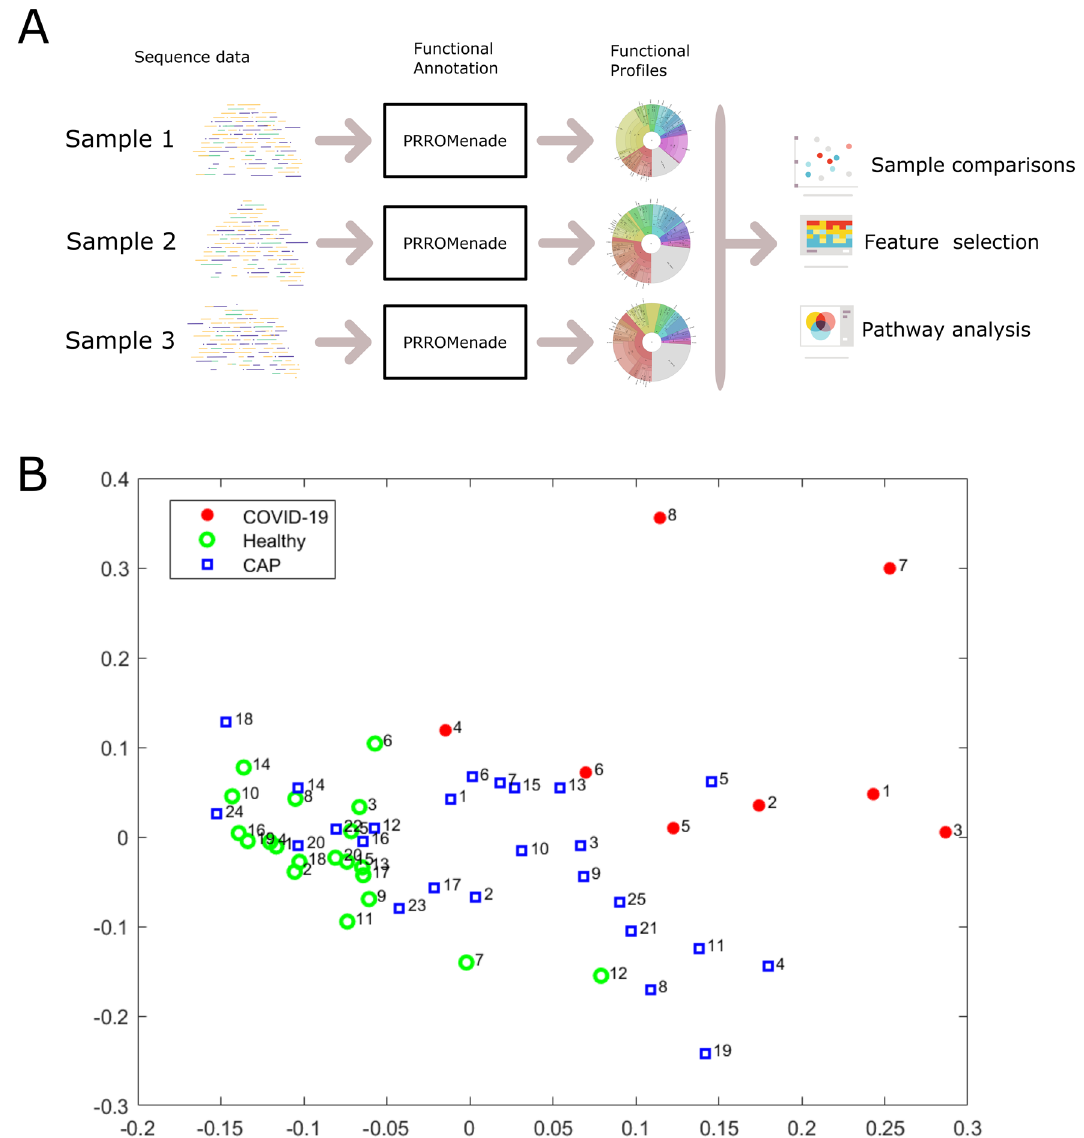
Figure 1. Overall analysis workflow and two-dimensional projection of functional profiles. ( A ). Each microbiome sequencing sample is annotated with PRROMenade, utilizing labeled reference data from the IBM Functional Genomic Platform. The resulting functional profiles are visualized and compared in downstream analyses. ( B ). Multidimensional scaling of the functional profiles using the Spearman distance. Each sample is represented by a marker colored by cohort and labeled by the sample number within that